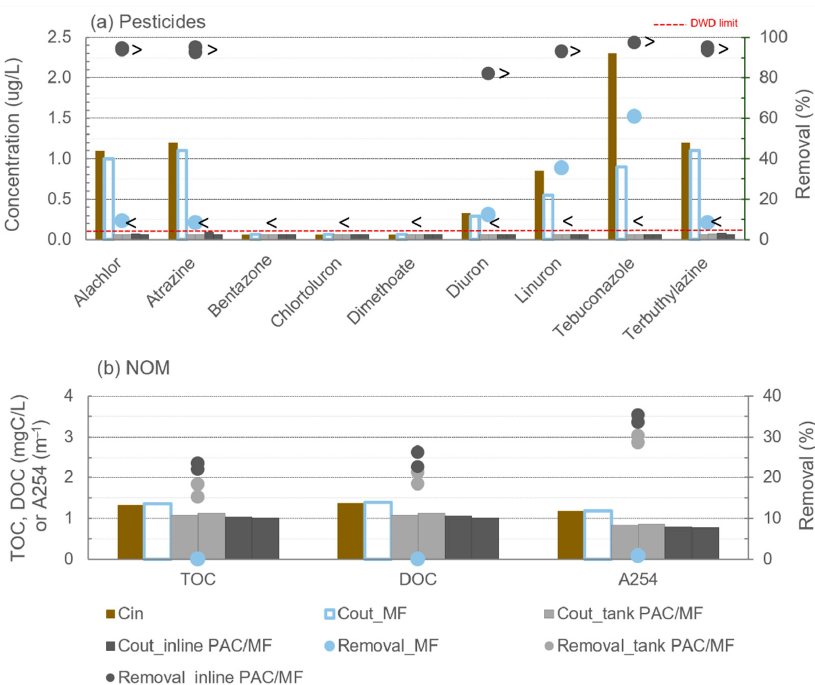
Figure 3. Pesticides’ concentrations ( a ) and NOM content ( b ) in trial 1: intake (W1) and permeate concentrations (bars) and removals (circles) after MF or PAC/MF with 10 mg/L PAC dosing, inline or to tank (“<” represents concentrations below LOQ and “>”removals computed with LOQ; doted red line is the Drinking Water Directive limit for pesticides).